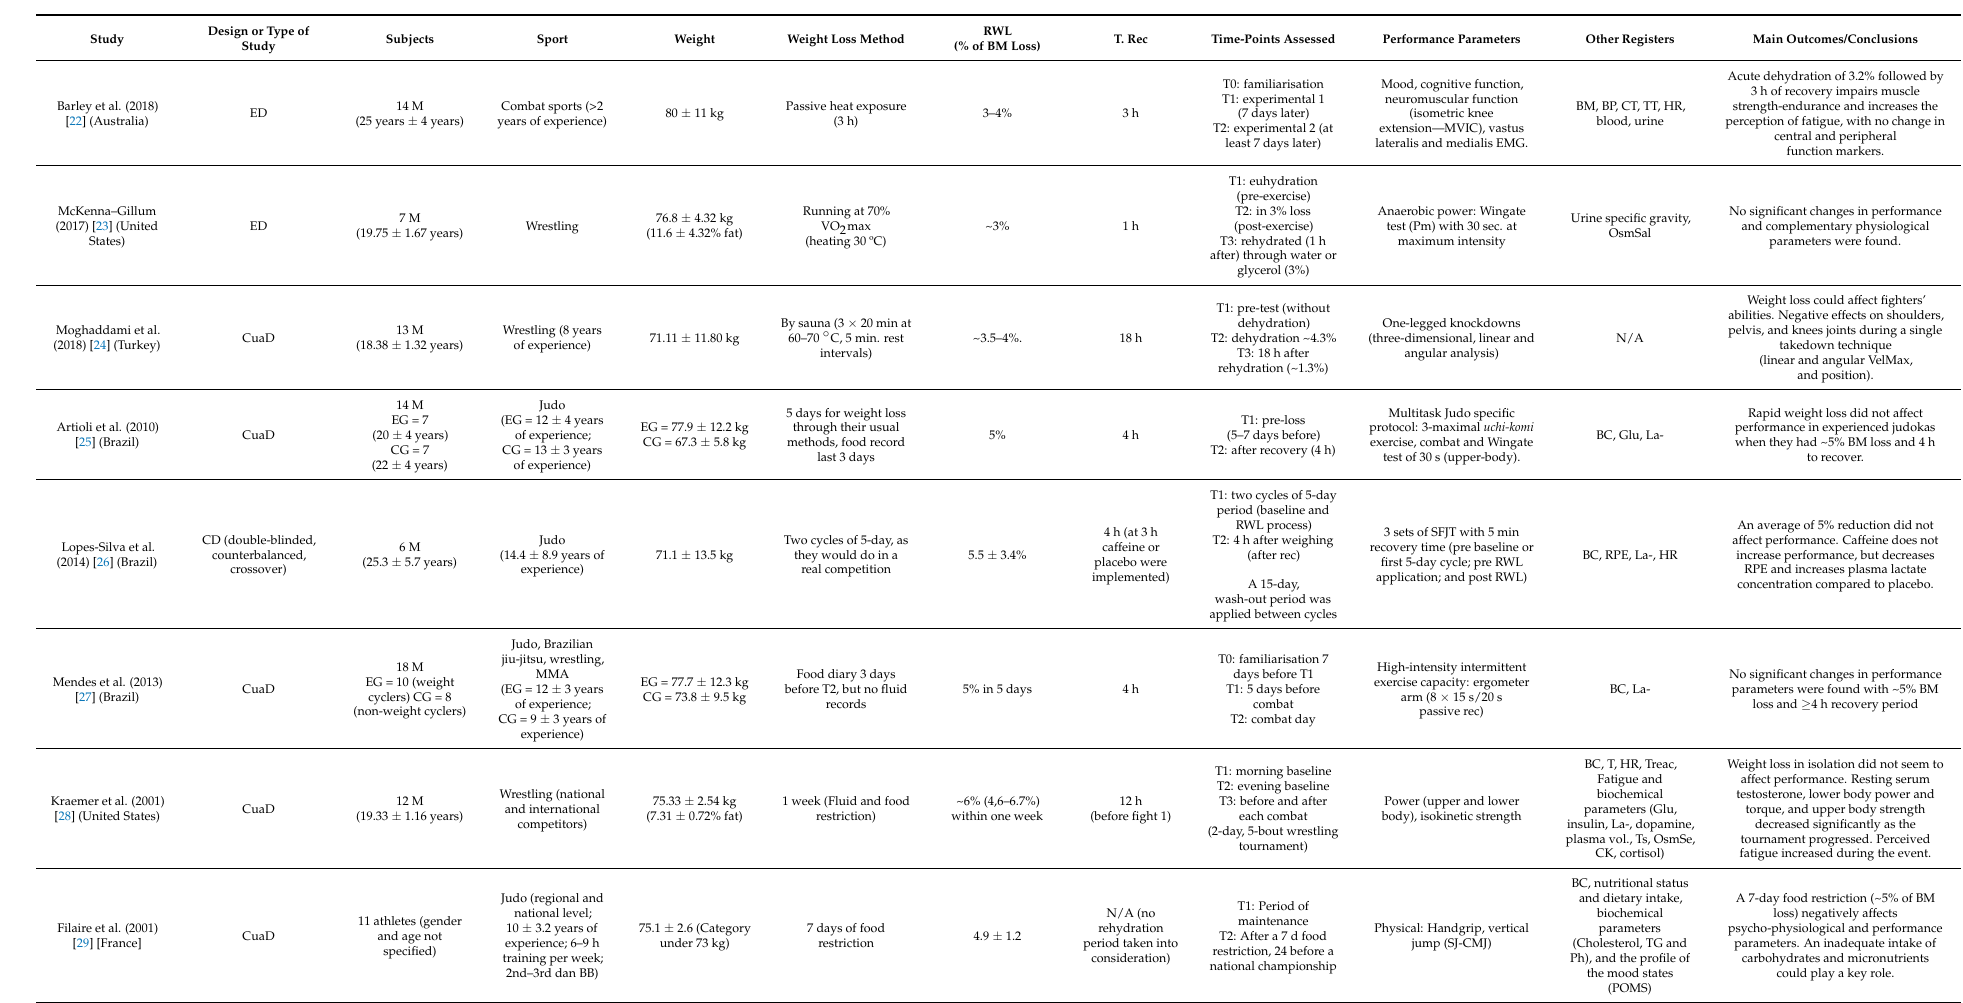
Table 2. Characteristics and main outcomes of the